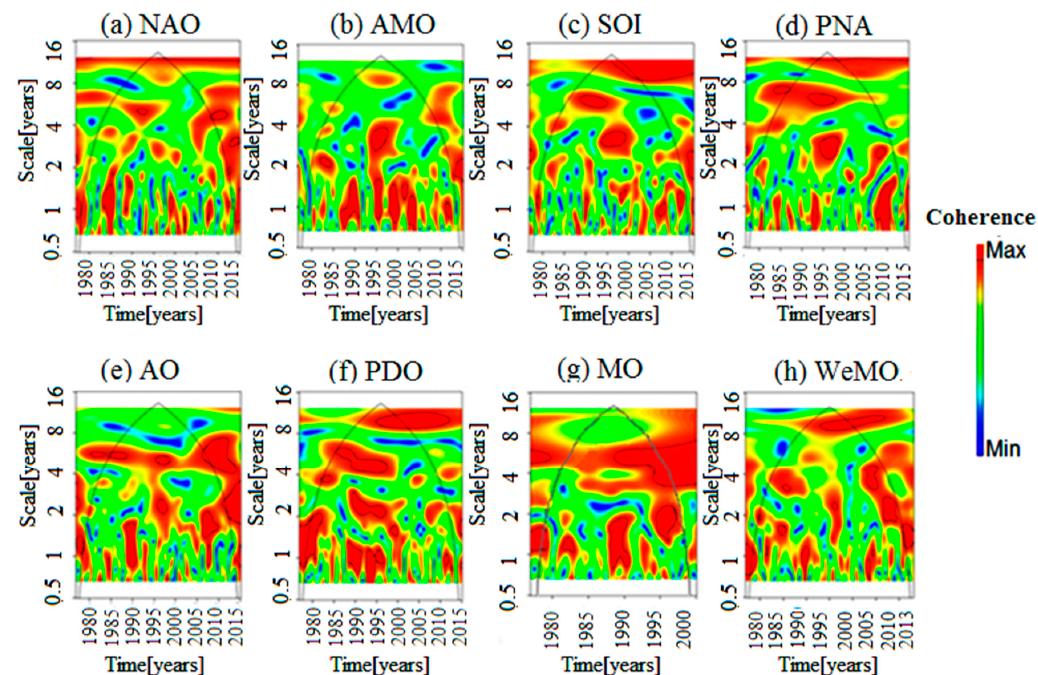
Figure 6. Spectrum of Wavelet coherence for climate indices and precipitation in station 2. ( a ) NAO: North Atlantic Oscillation, ( b ) AMO: Atlantic Multidecadal Oscillation, ( c ) SOI: Southern Oscillation Index, ( d ) PNA: Pacific–North-America teleconnection, ( e ) AO: Arctic Oscillation, ( f ) PDO: Pacific Decadal Oscillation, ( g ) MO: Mediterranean Oscillation, ( h ) WeMO: West Mediterranean Oscillation.